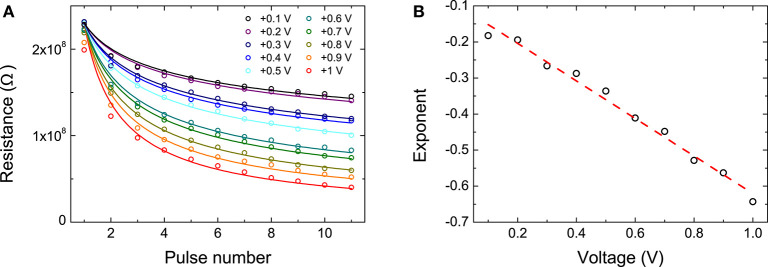
(A) Circles show the experimental data of device resistance after the application of multiple SET pulses with amplitudes varying from +0.1 V (top branch) to +1 V (bottom branch). Lines represent fits to Equation (5). (B) Black circles show the exponents extracted from the fits in (a) as a function of pulse voltage. The red line is a linear regression fit from which the a and b parameters are obtained.